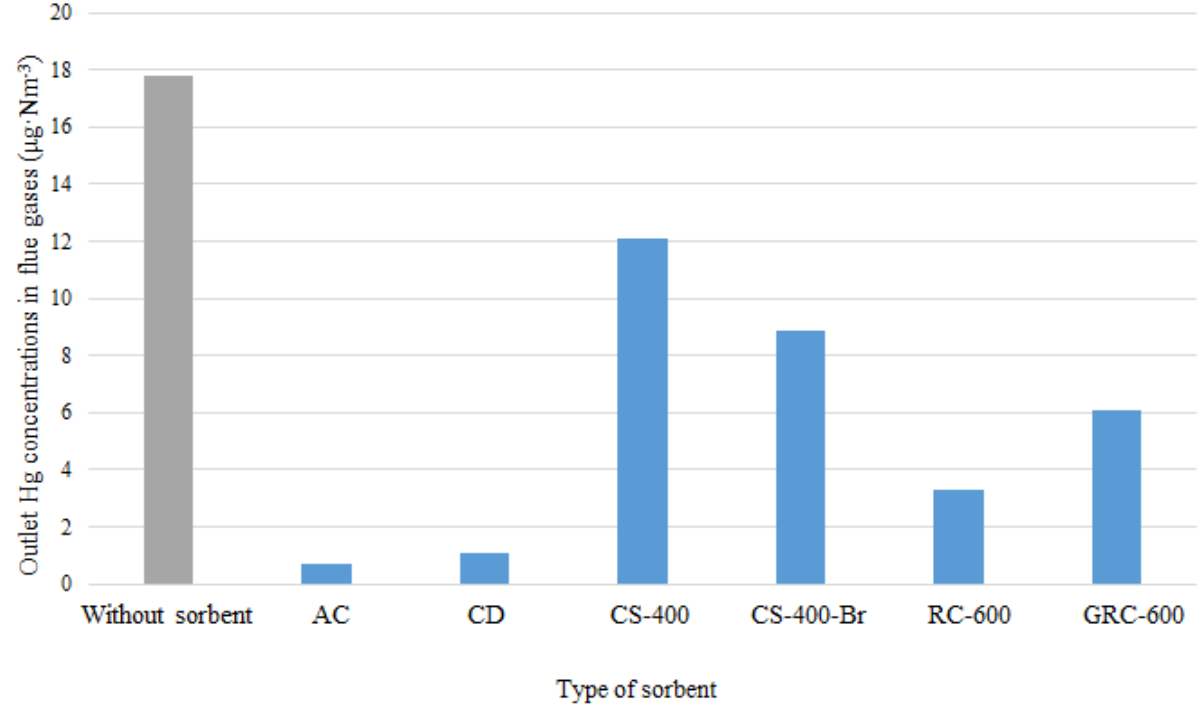
Figure 5. Concentration of mercury in raw flue gas and flue gases cleaned by LCOA.